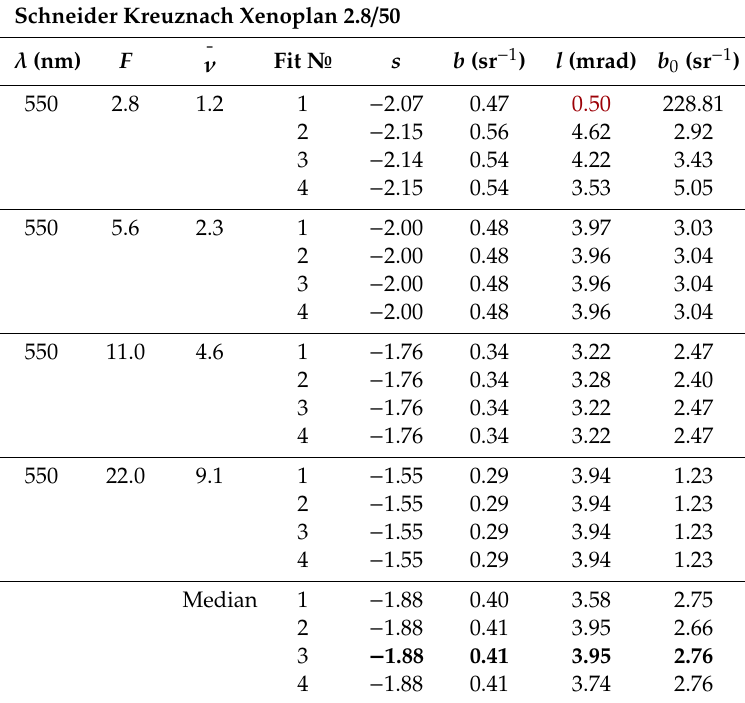
Table A7. Fit results for the lens Schneider Kreuznach Xenoplan 2.8 / 50. Schneider Kreuznach Xenoplan 2.8 / 50